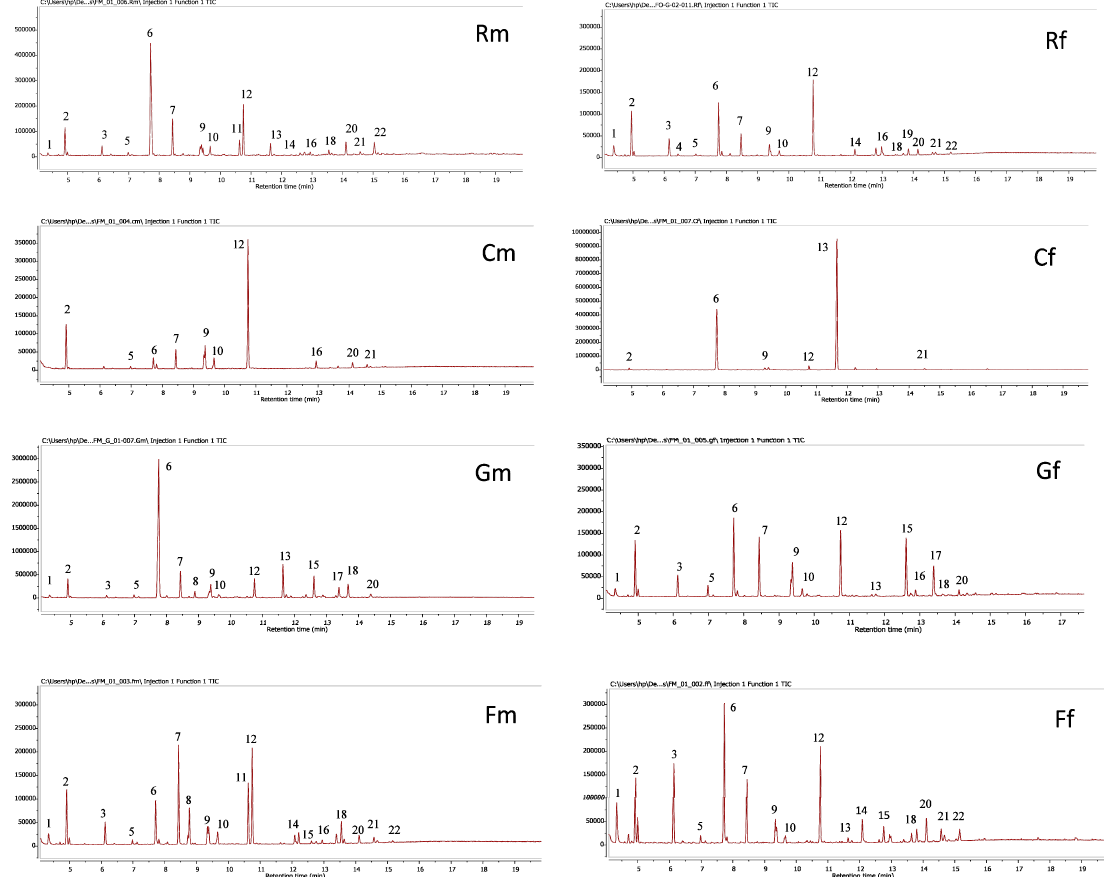
Figure 1. Chromatographic profile of different parts (roots, seeds, leaves, and capitula) of the two varieties A. P var. pyrethrum (L.) and A. P var. depressus (Ball): Rm: roots of. P var. pyrethrum (L.); Gm: seeds of A. P var. pyrethrum (L.); Fm: leaves A. P var. pyrethrum (L.); Cm: capitula of A. P var. pyrethrum (L.); Rf: roots of A. P var. depressus (Ball) Maire; Gf: seeds of A. P var. depressus (Ball) Maire; Ff: leaves of A. P var. depressus (Ball) Maire; Cf: capitula of A. P var. depressus (Ball) Maire.